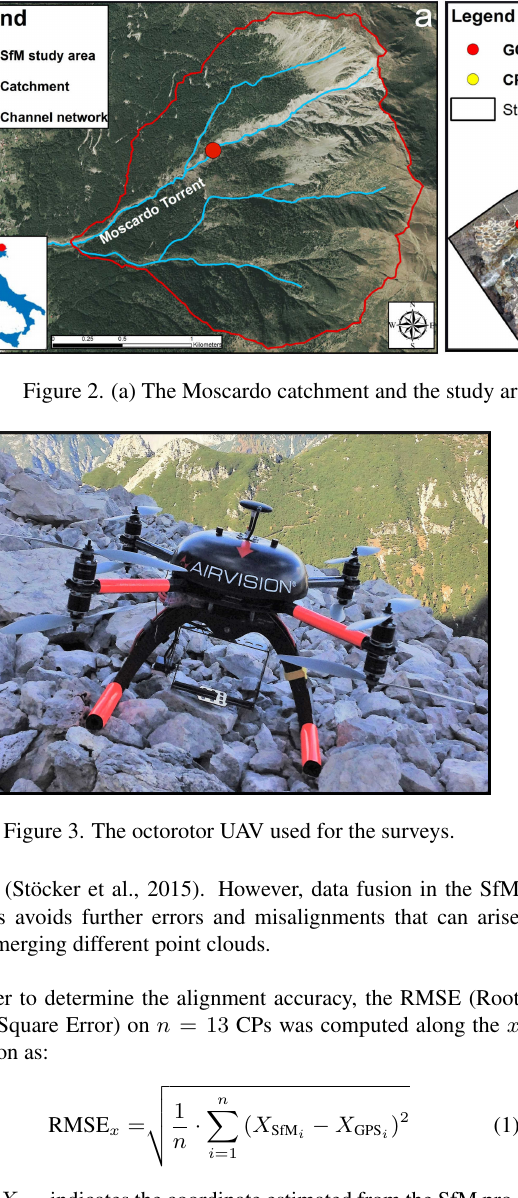
Figure 4. Detail of boulders reconstructed in the dense point clouds by 3DFZ (a) and PS